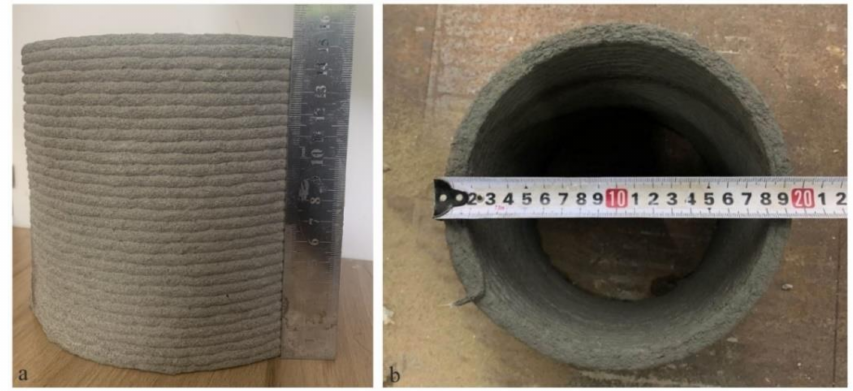
Figure 9. The printed specimen D200V40OSS3. ( a ) Side view and ( b ) plan view. The printed cylinder D200V40OSS3 consisted of 30 layers and took about 8 min to